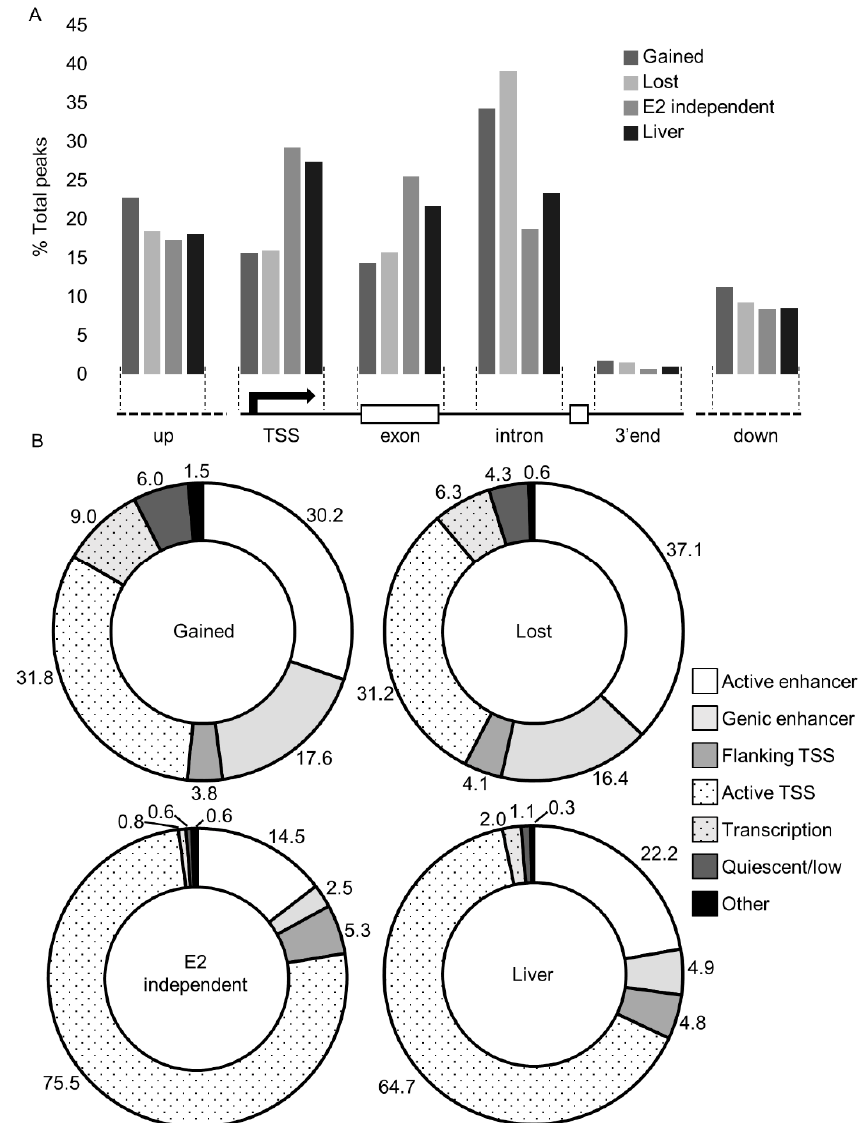
Figure 2. Genomic localization of ESR1. ( A ) Spatial localization determined by comparison of peaks to gene annotation in the UCSC genome browser. Values are percentages of total peaks in each region from each sample. Location is depicted in the cartoon below the graph, in the following order (left to right): upstream ( − 500 to − 10 kb of TSS, up), proximal promoter ( ± 2 kb of transcription start site, TSS), exonic, intronic, 3 ′ -end (±500 bp from transcription end site), and downstream (+500 to +10 kb of TES, down). ( B ) Localization as determined by epigenetic histone marks. Values are percentages of total peaks. ChromHMM [23] was trained with data from liver samples and used to categorize the ESR1 peaks. TSS, transcription start site.